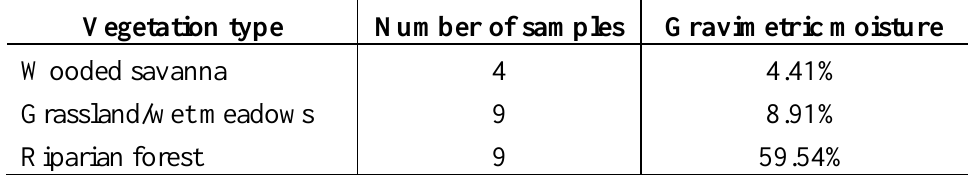
Table 2. Summary of gravimetric soil moisture data collected in the study